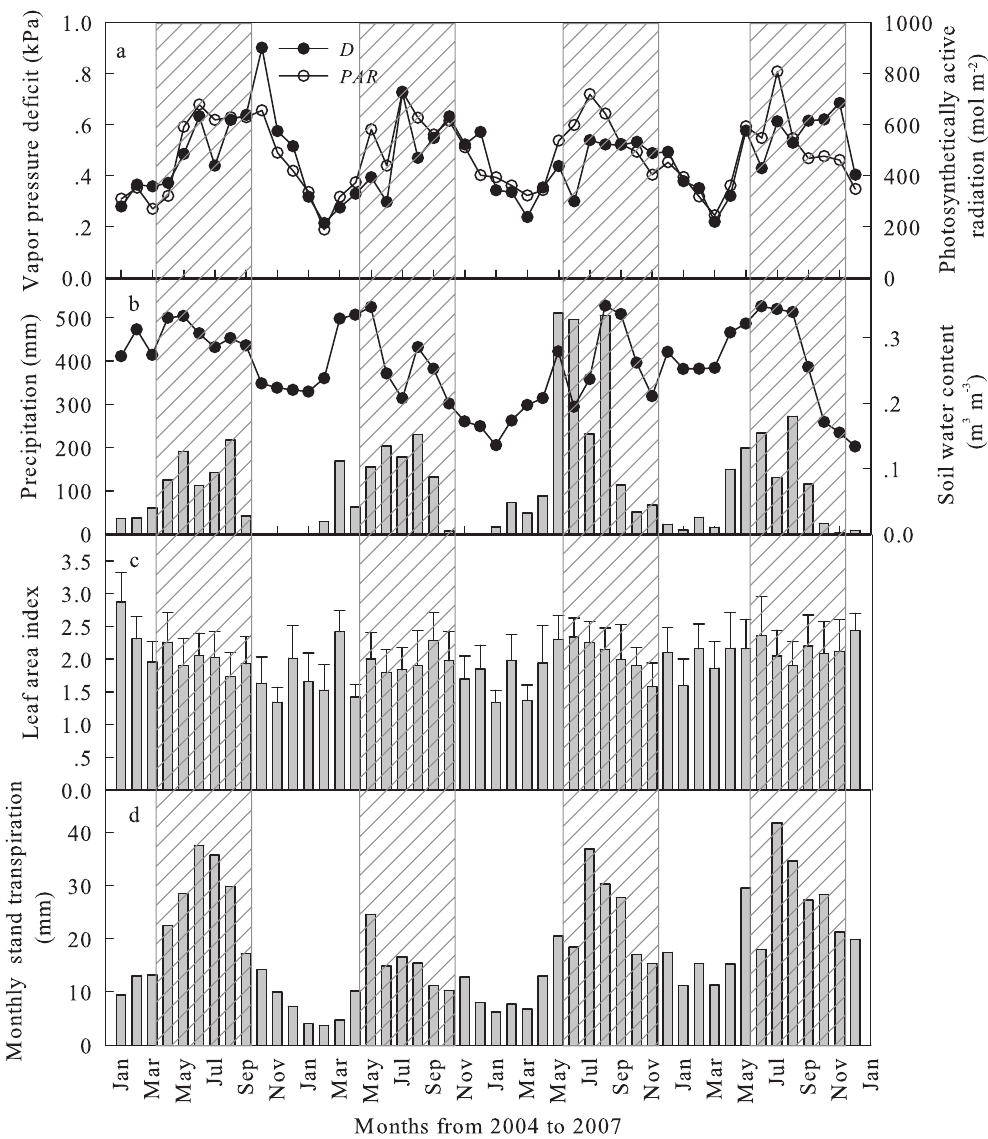
Fig. 1. (a) Monthly mean vapor pressure deficit ( D) and photosynthetically active radiation (PAR) at the experimental site; (b) precipitation ( P) and monthly mean soil water content (SWC) at the experimental site; (c) monthly mean leaf area index (LAI) and (d) stand transpiration ( E L ) of A. mangium . Error bars indicate standard deviation ( n = 20). Boxes filled with the coarse pattern in gray color indicate the wet